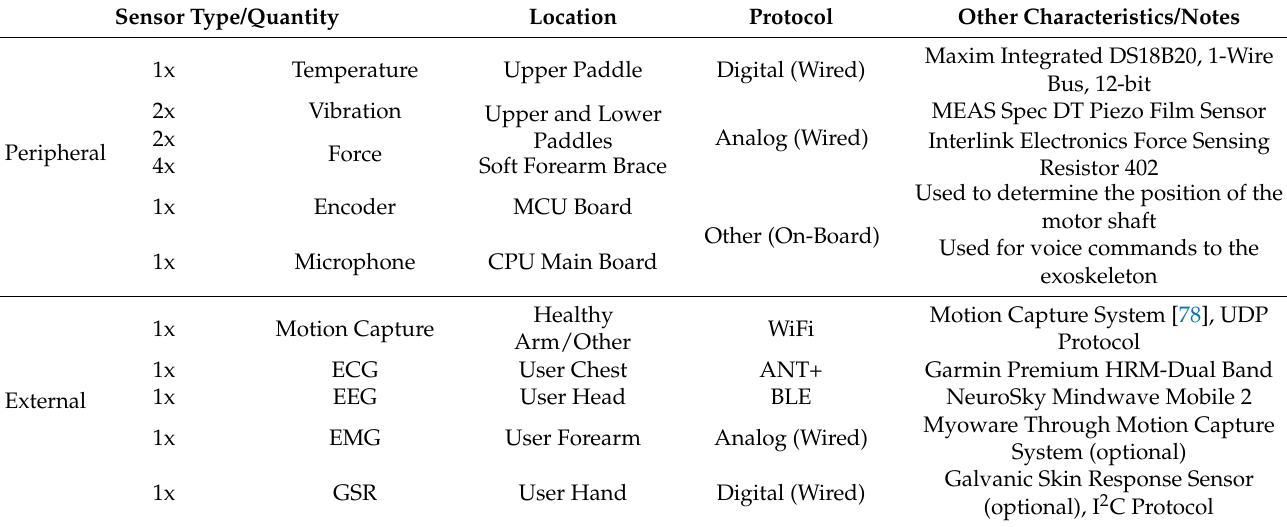
Table 2. Summary of the internal and external sensors of the exoskeleton prototype.